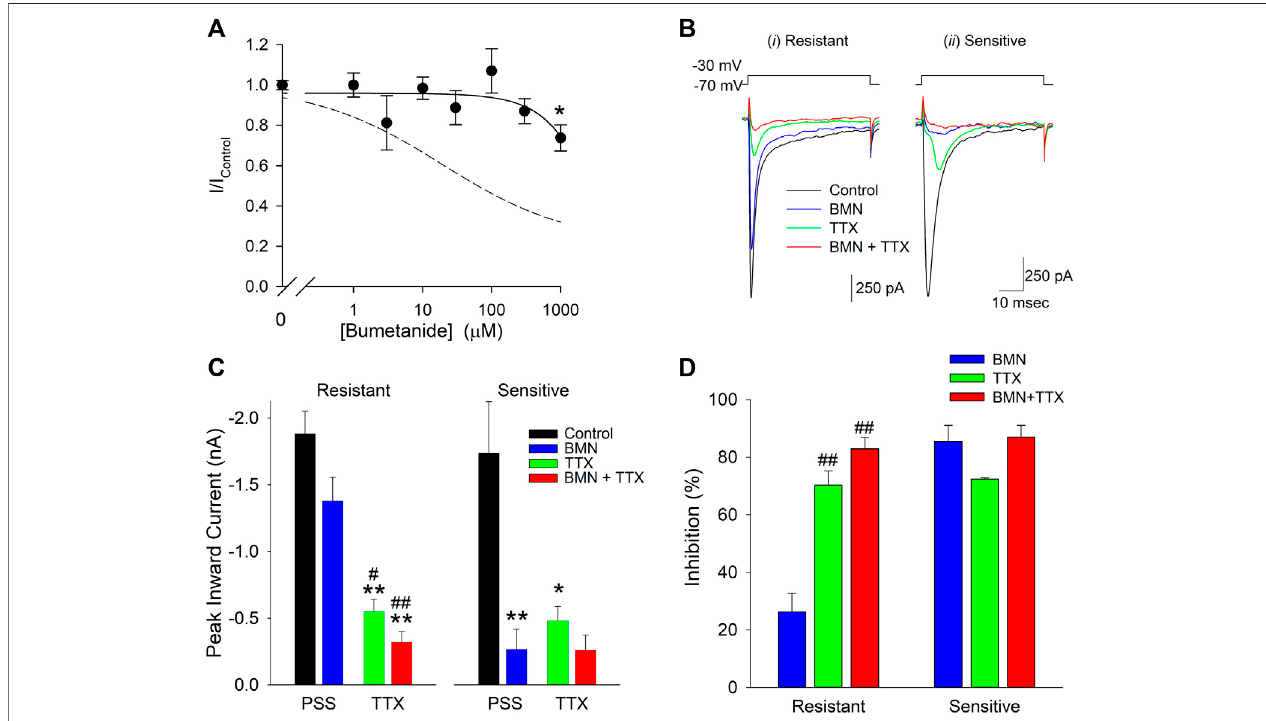
FIGURE 7 | Sensitivity to inhibition by bumetanide distinguishes two populations of voltage-gated sodium channels in cultured neurons. (A) , Normalized peak inward VGSC currents (mean ± SEM) as a function of bumetanide concentration recorded from neurons with VGSC resistant to bumetanide blockade ( n > 7). Currents were activated by voltage steps from a holding potential of − 70 mV to − 30 mV and normalized to control peak currents measured in the absence of bumetanide at the indicatedconcentrations.Datapointswerebest fi t(solidline)toalinearequationwithaslopeof − 0.2 nM − 1 .Dottedlineisthesingle-siteLangmuir-Hillequation fi